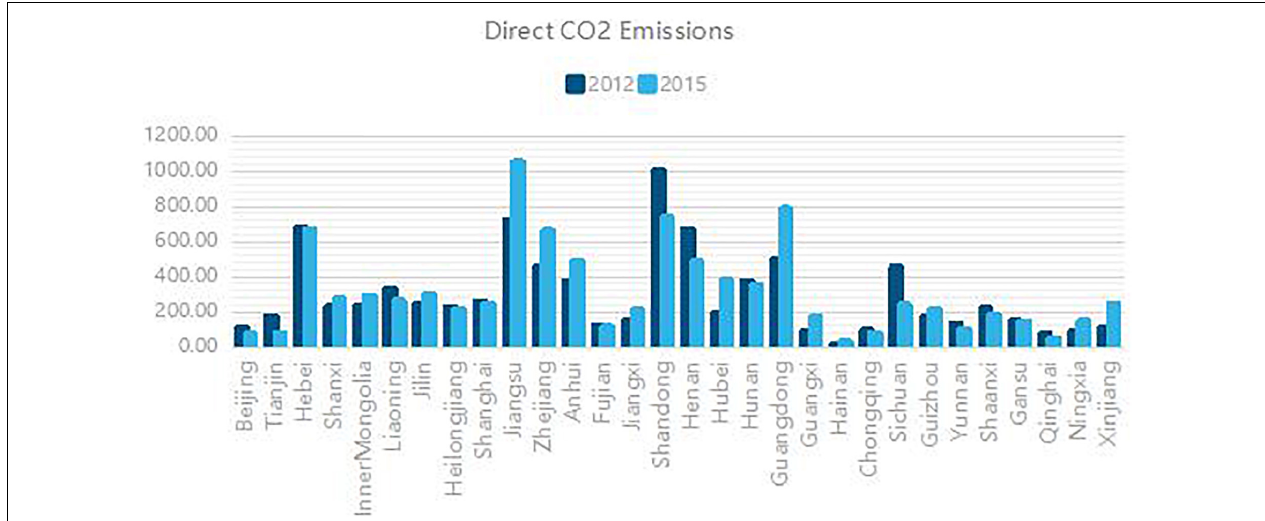
FIGURE 1 | Direct CO 2 emissions in 2012 and